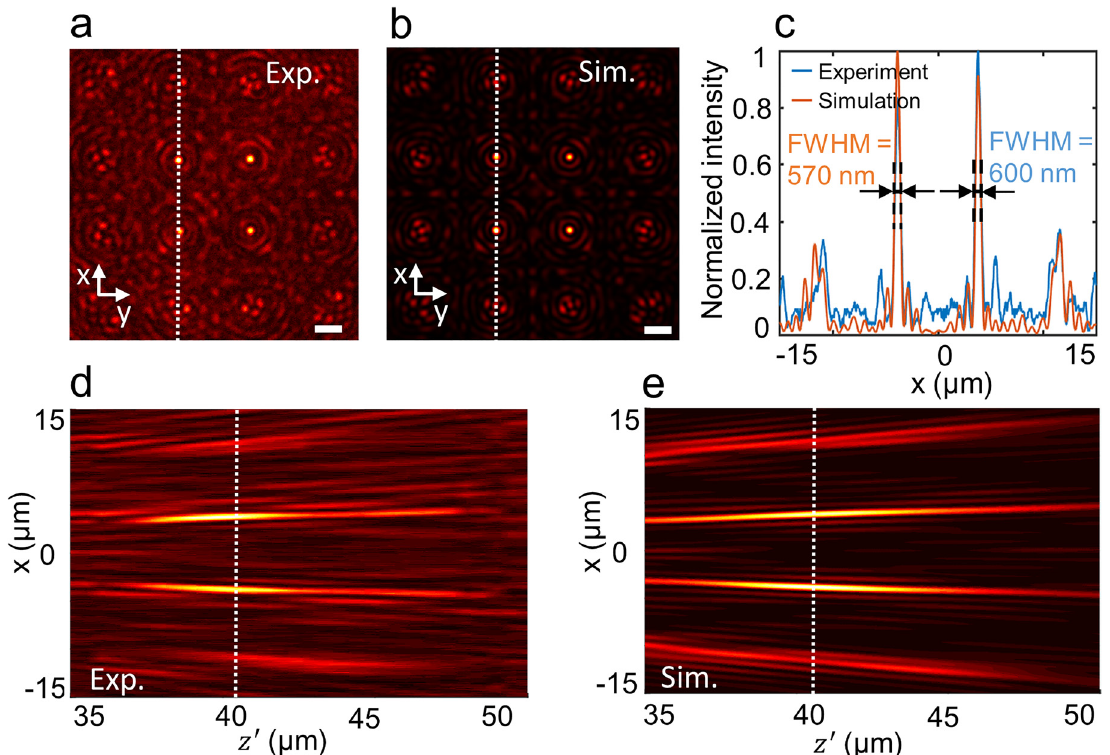
Figure7: Simulationandexperimental resultsof Besselbeamarrays(a) Experimentaland(b)simulatedtransverse fi elddistributionsof the4 × 4 array of Bessel beams with NA = 0.4 at the designated wavelength λ – y plane. Scale bar = 5 µm. (c) The orange and blue d = 630 nm in the x pro fi les represent the cross-section distributions at the position of the white dashed line in (a) and (b). (d) Experimental and (e) simulated longitudinal fi eld distributions of the beam pattern along the propagation direction.